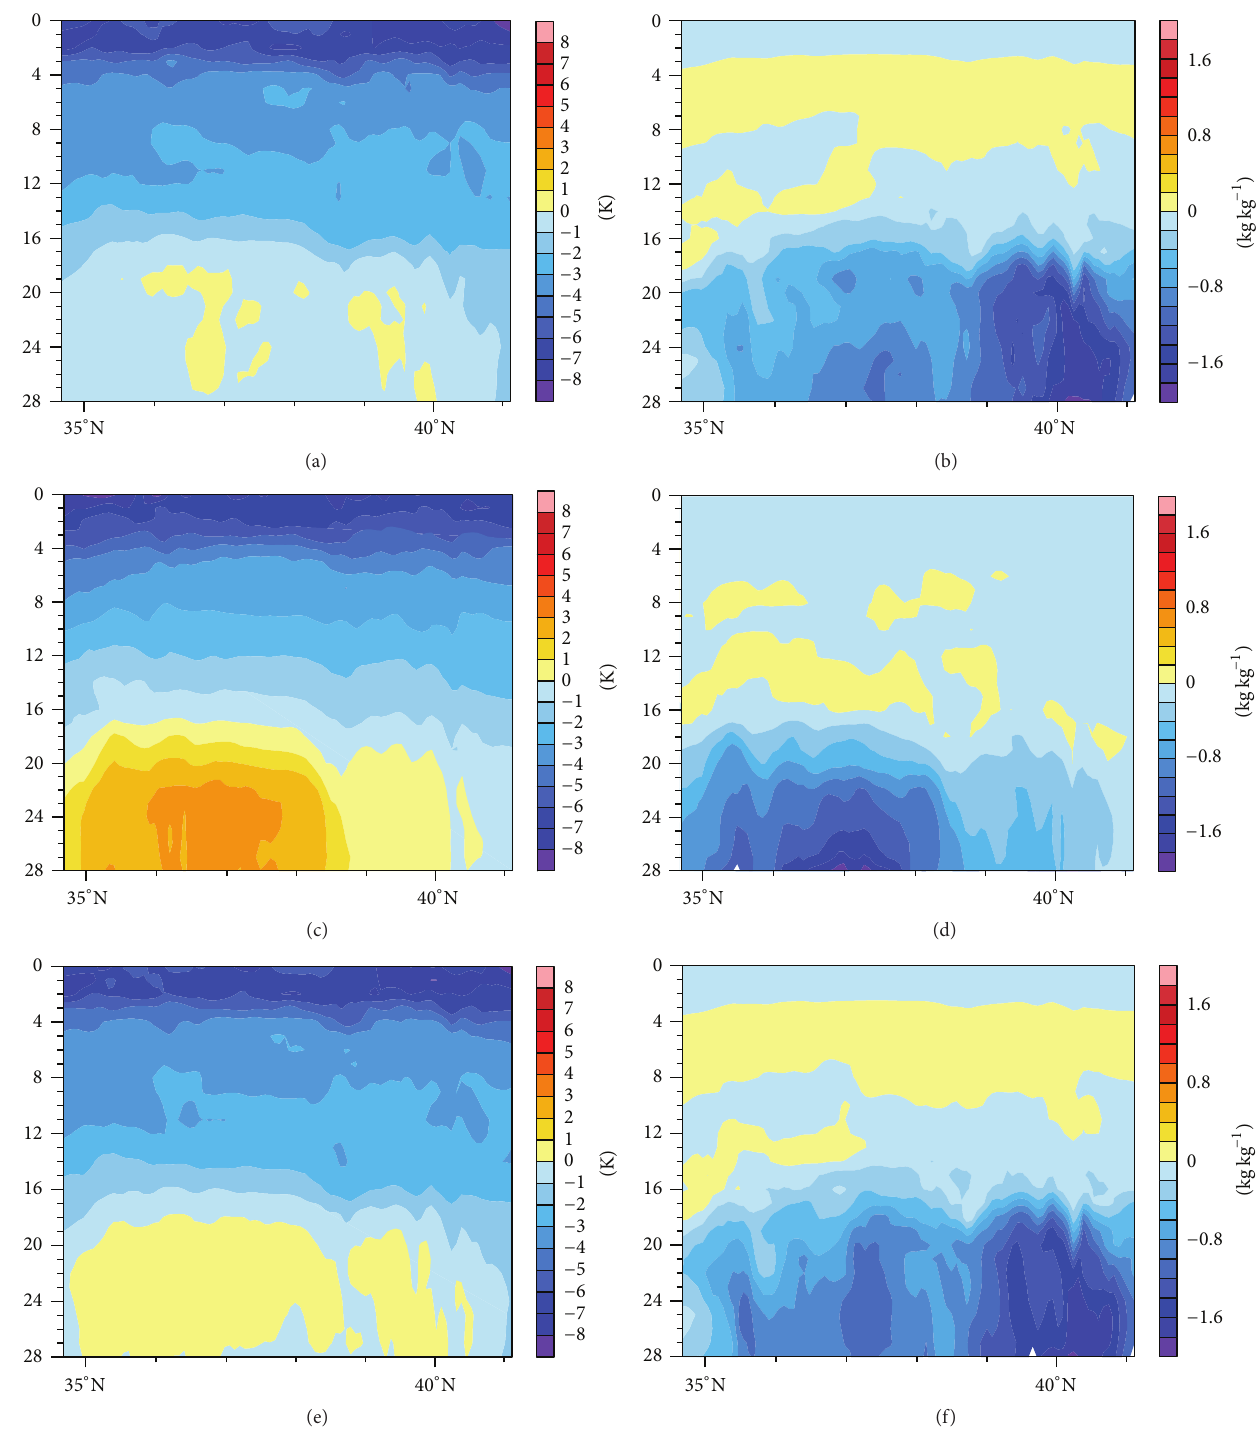
Figure 10: Vertical profile difference for the average potential temperature and water vapor mixing ratio along 100.46 ∘ E in June: (a) INTL- CTRL for potential temperature, (b) INTL-CTRL for water vapor mixing ratio, (c) MODS-CTRL for potential temperature, (d) MODS-CTRL for water vapor mixing ratio, (e) INMO-CTRL for potential temperature, and (f) INMO-CTRL for water vapor mixing